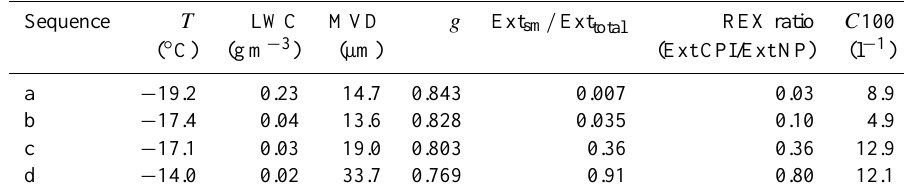
Table 1. Mean values of the cloud parameters over the times-sequences labelled a to d on Fig. 1. The parameters are the temperature, the liquid water content, the mean volume diameter, the asymmetry parameter, the second mode on total extinction calculated with FSSP PSD, the CPI on PN extinctions ratio (REX) and the concentration of ice particles (with d > 100µm).